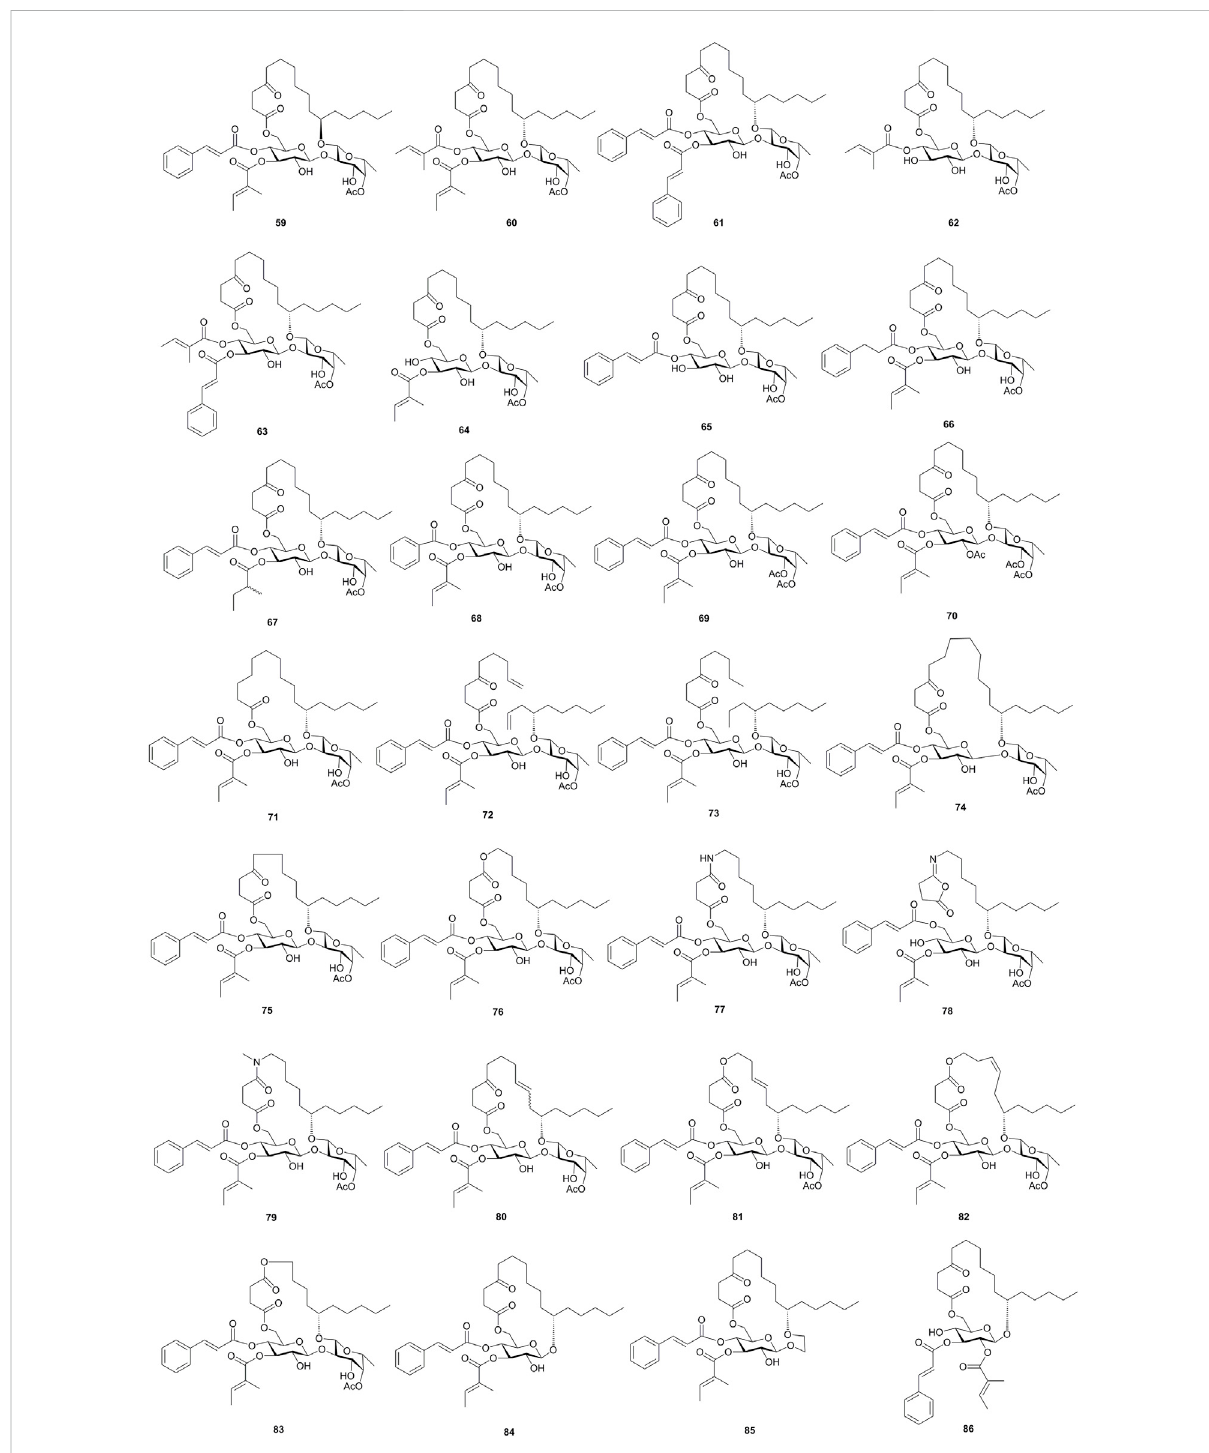
FIGURE 7 Structures of synthesized ipomoeassins F analogues 59 – 86 .